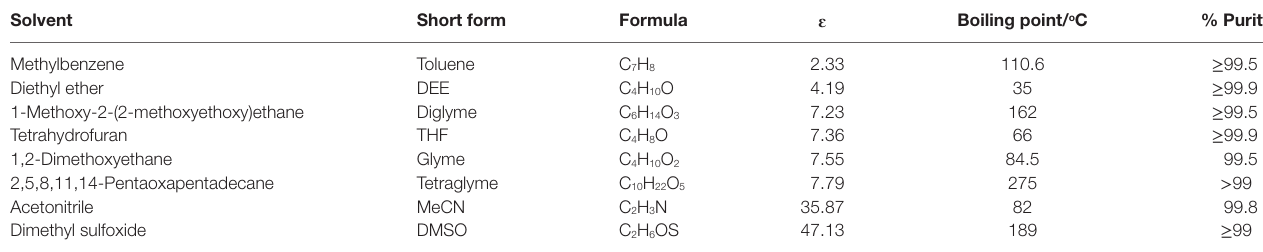
Table 1 | List of Solvents used and their properties, adopted from CRC (2003–2004) and Wohlfarth (2008) ( ɛ = dielectric constant).